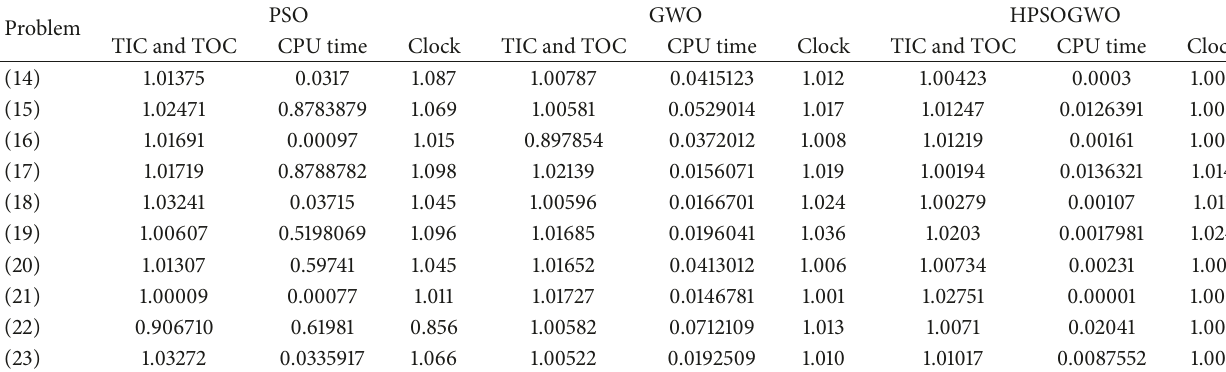
Figure 3: Convergence curve of PSO, GWO, and HPSOGWO variants on fixed-dimension multimodal functions. Table 12: Time-consuming results of fixed-dimension multimodal benchmark